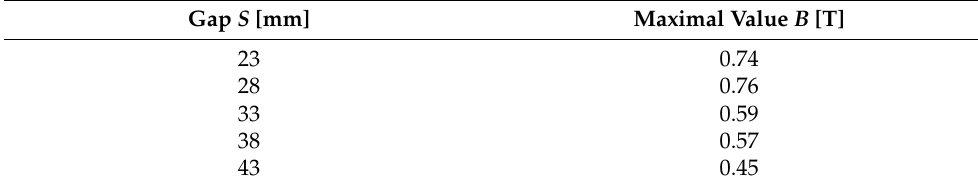
Table 6. Maximum measured values of magnetic induction B